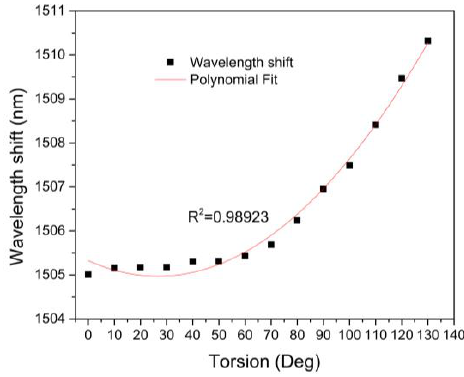
Figure 9. The Interference spectrum to dip centered at 1504 nm.